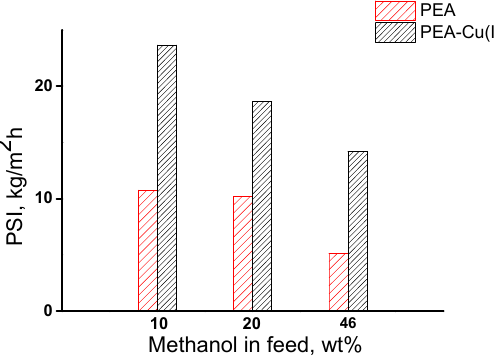
Figure 10. Dependence of pervaporation separation index on methanol concentration in the feed for РЕА and РЕА –Cu(I) membranes, 20 ° С .